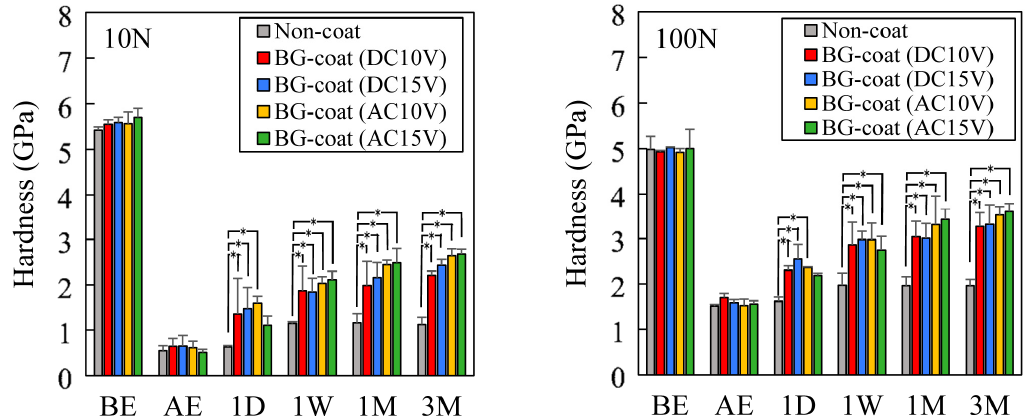
Figure 7. Mean hardness values of the enamel surface before and after etching, and during the 3-month month immersion period. BE, before etching; AE, after etching; 1D, 1 ‐ day immersion; 1W, 1 ‐ week immersion period. BE, before etching; AE, after etching; 1D, 1-day immersion; 1W, 1-week immersion; immersion; 1M, 1 ‐ month immersion; 3M, 3 ‐ month immersion. 1M, 1-month immersion; 3M, 3-month